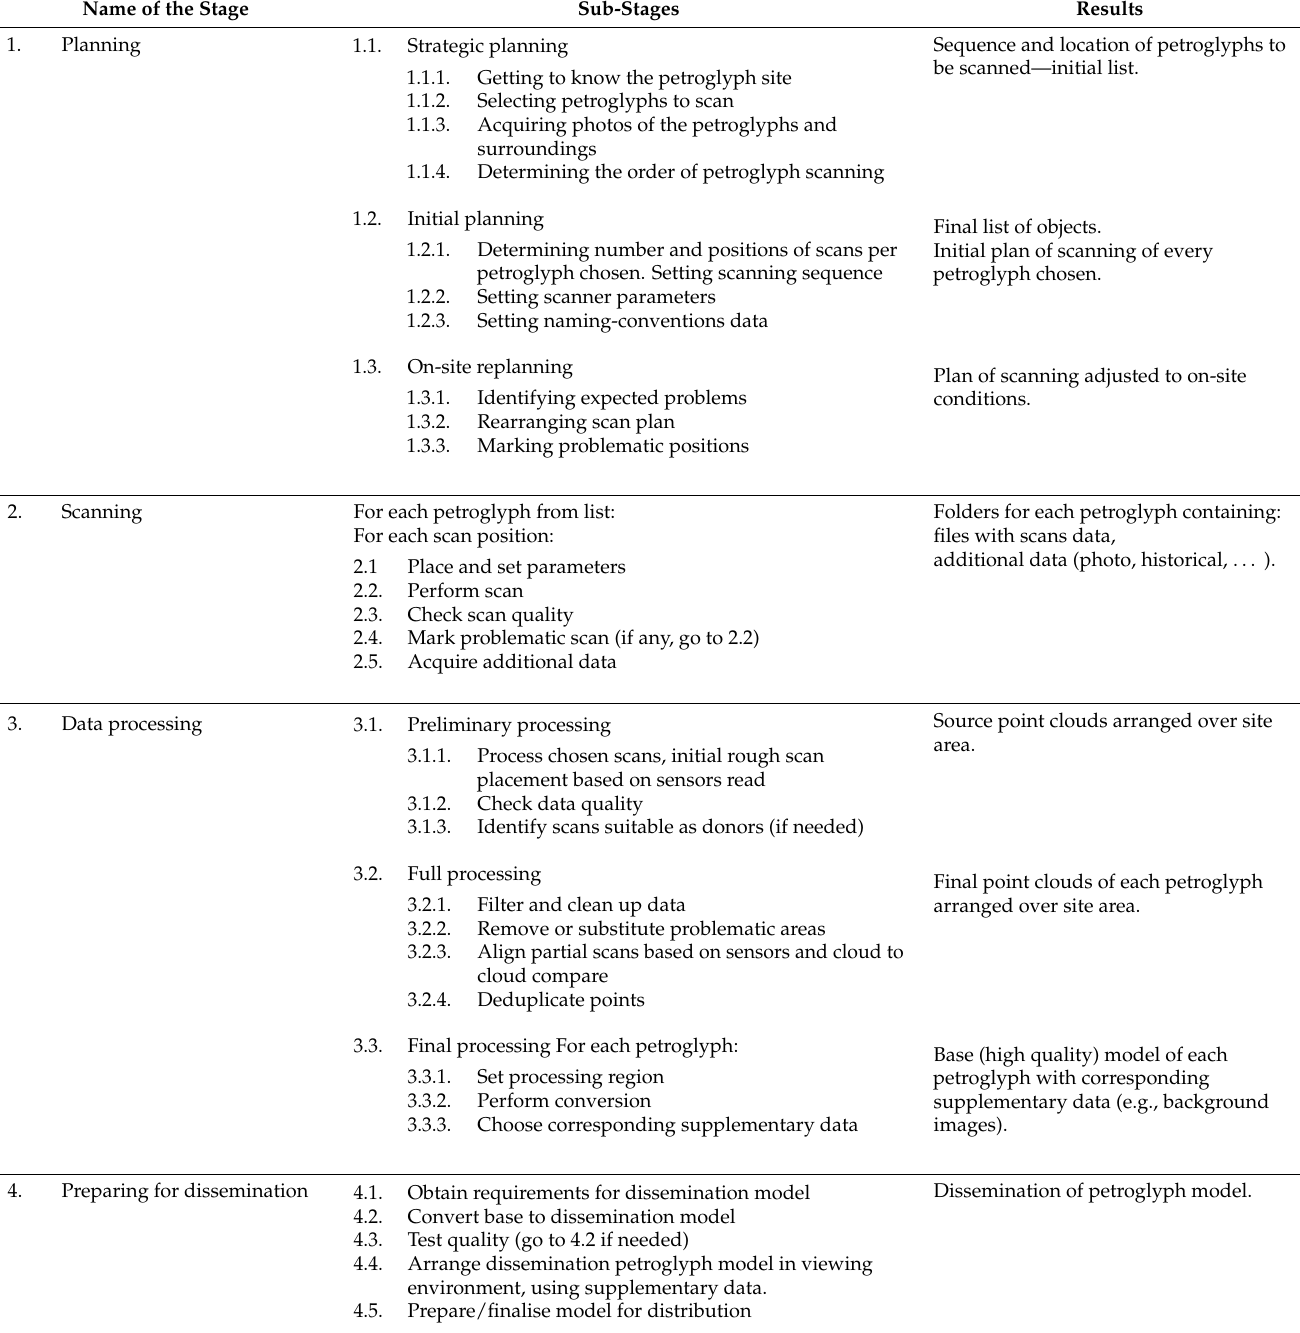
Table 1. Adapted 3DScaMITE [9] methodology for scanning